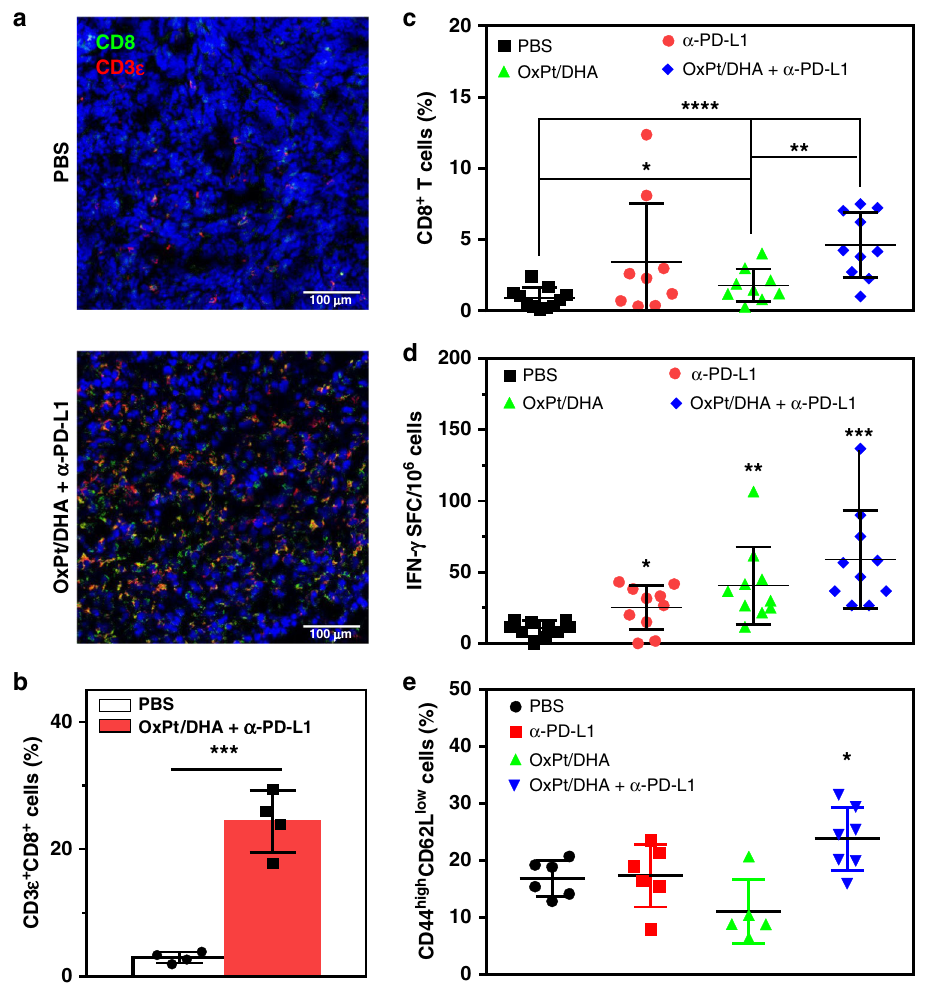
Fig. 8 OxPt/DHA promotes tumour-speci fi c T cell response. a Immuno fl uorescence analysis showing the in fi ltration of CD8 + T cells 12 days after the fi rst treatment. b The density of CD8 + T cells in the tumour sections, analysed from the confocal images of immuno fl uorescence staining ( n = 3). c CD8 + T cells in tumours by fl ow cytometry of cell-surface staining 12 days after the fi rst treatment. d KSPWFTTL antigen-speci fi c IFN- γ producing T cells detected by ELISPOT assay 12 days after the fi rst treatment. e The percentage of effector memory T cells in total CD8 + T cells in spleens after treatment with OxPt/DHA plus α -PD-L1. Data are each pooled from two independent experiments for ( c ) − ( e ). * p < 0.05, ** p < 0.01, *** p < 0.001 and **** p < 0.0001 by Student ’ s two-tailed t test. OxPt oxaliplatin, DHA dihydroartemisinin, ELISPOT Enzyme-Linked